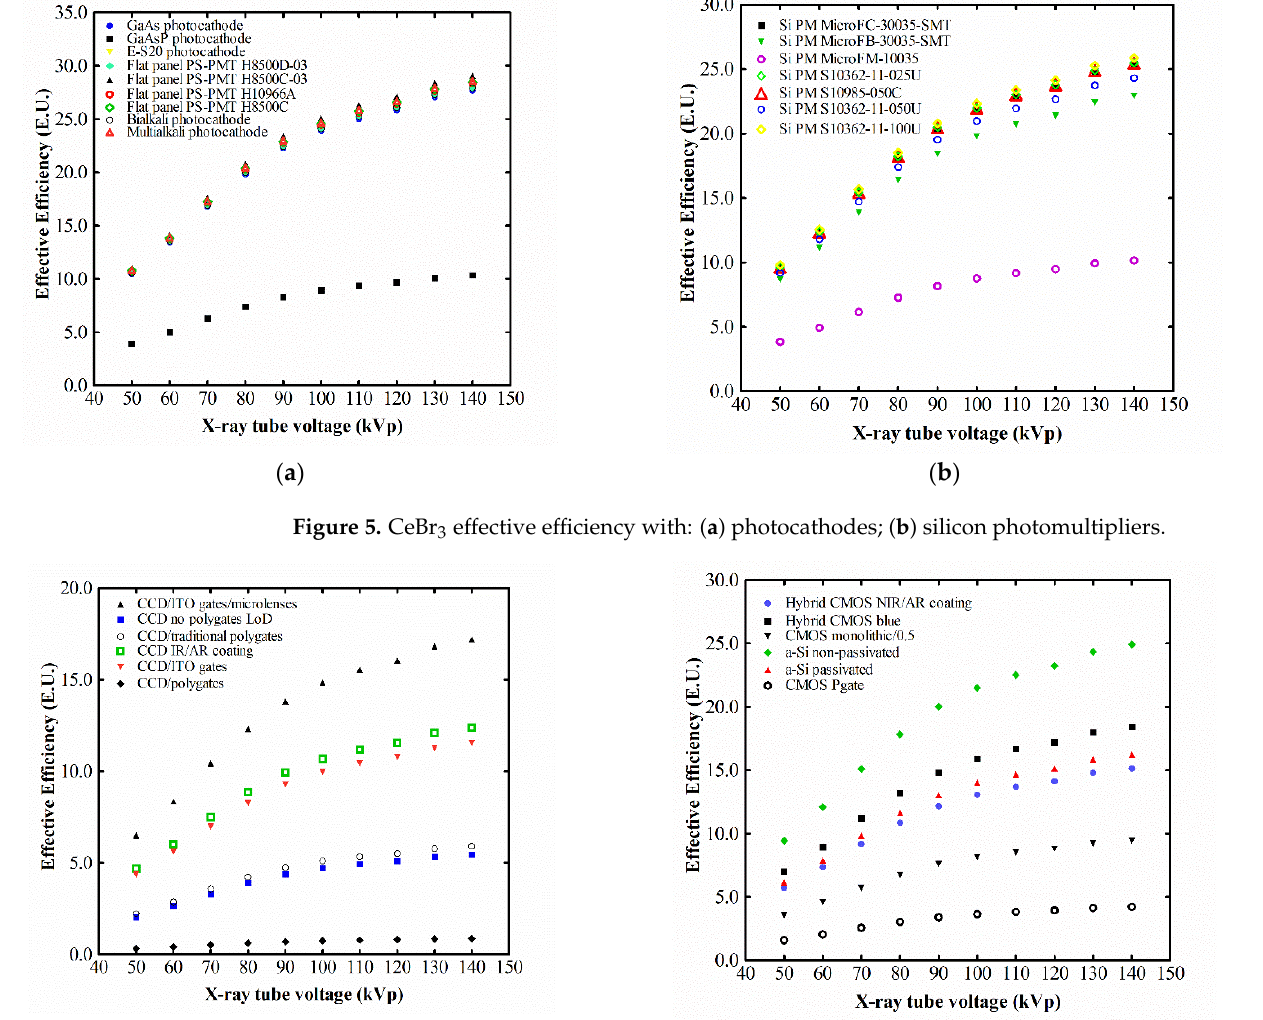
Figure 4. CeBr 3 spectral matching with: ( a ) charge-coupled-devices; ( b ) complementary metal-oxide semiconductors.